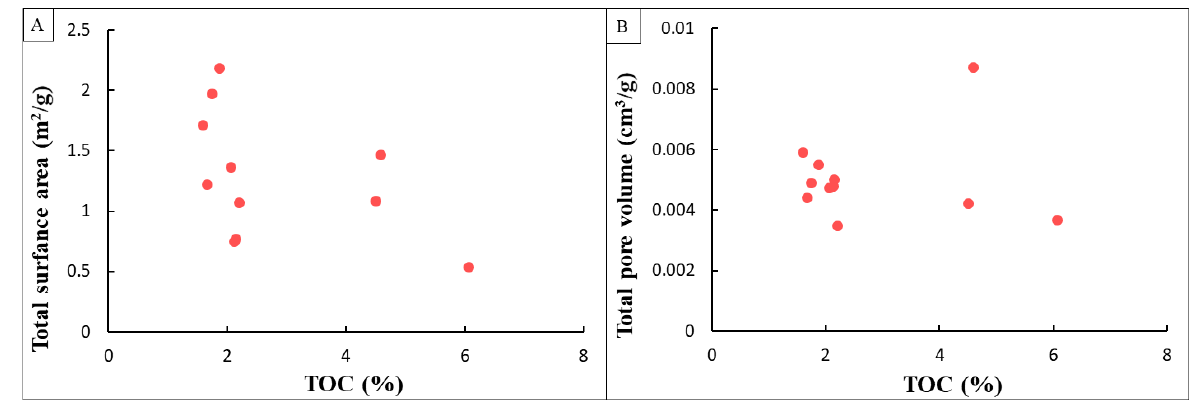
Figure 11. ( A ) Correlations between TOC and total surface area of the shales in the study area. ( B ) Correlations between TOC and pore volume of the shales in the study area.